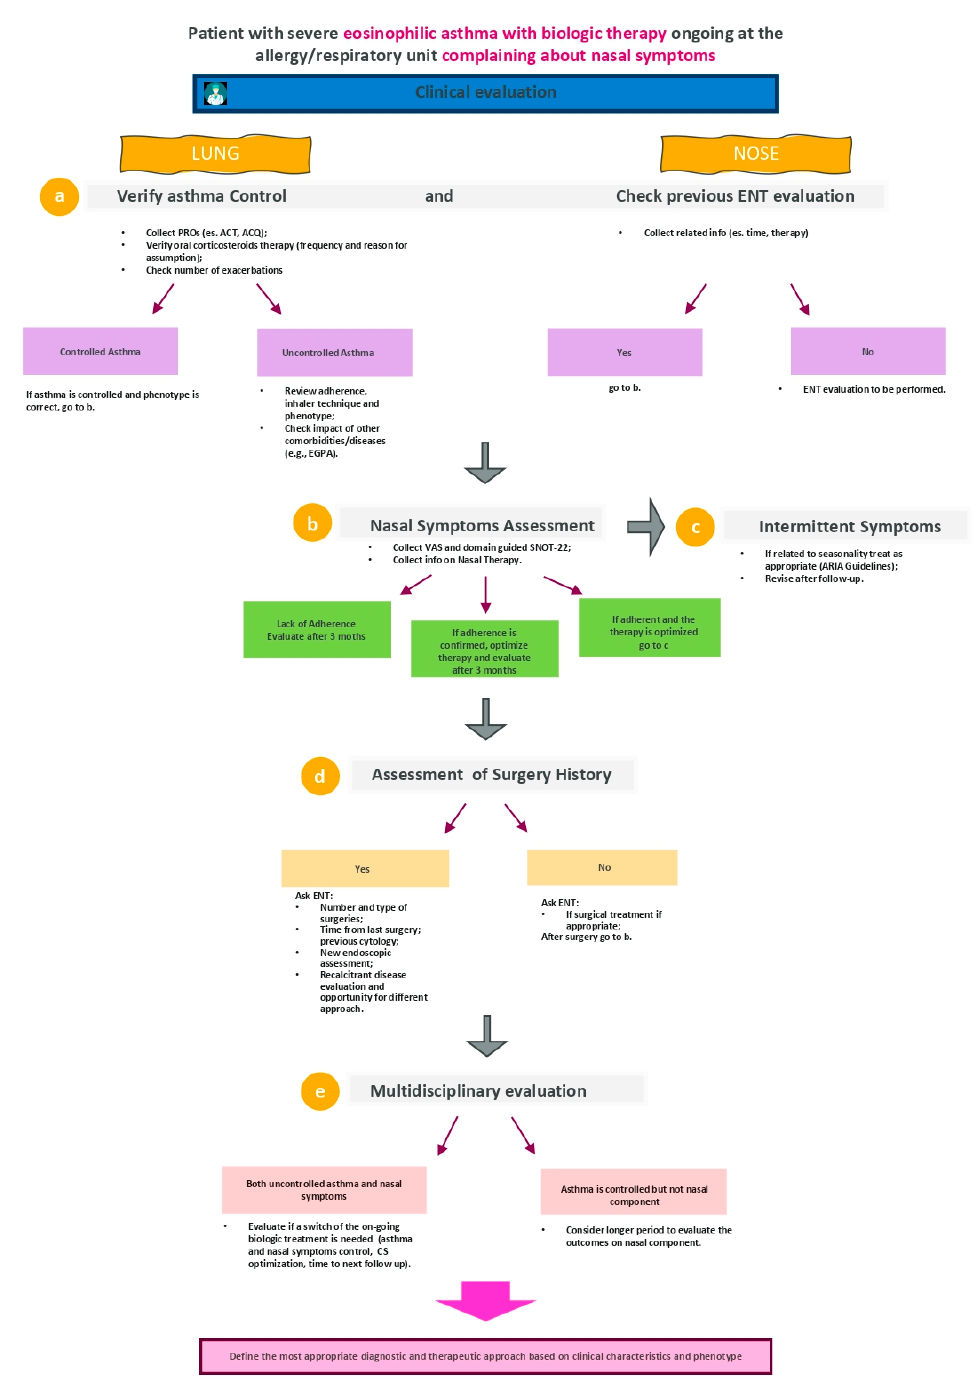
Figure 4. Flow for the management of a patient with severe eosinophilic asthma with ongoing biologic therapy at the allergy/pulmonary unit complaining about nasal symptoms. EGPA = eosinophilic granulomatosis with polyangiitis; VAS = visual analogic scale; SNOT-22 = sino-nasal outcome test on 22 items; ENT = ear, nose and throat specialist; ARIA = Allergic Rhinitis and its Impact on Asthma; PROs = patient-reported outcomes; ACT = asthma control test; ACQ = asthma control questionnaire; CS =